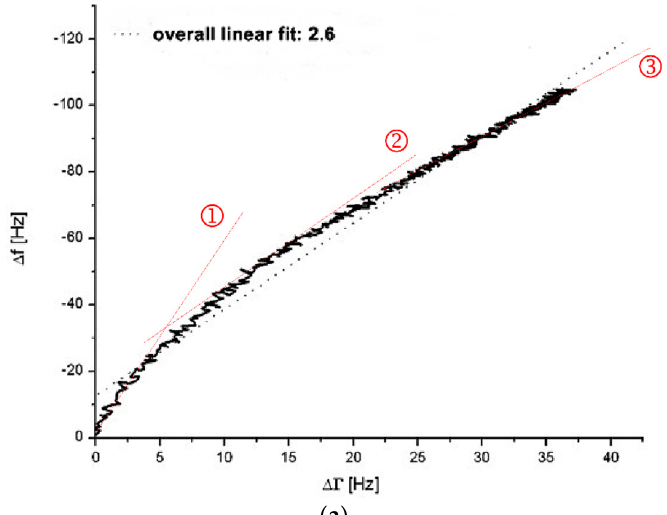
Figure 2. Cont . Figure 2.